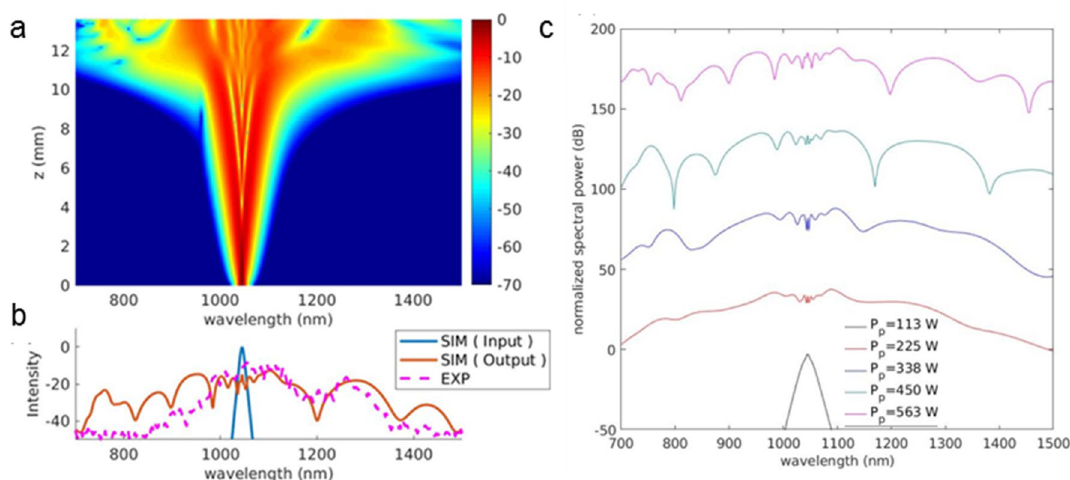
Figure 6. ( a ) Simulated SCG of TM 10 mode at the peak power of 563 W coupled into the Ta 2 O 5 waveguide: ( a ) spectral intensity; ( b ) comparison of the simulated (in red) and measured (in magenta) spectra at the output. The spectrum of the input pulse is shown in blue. ( c ) Estimated SC spectrum generated with ultrafast pulses of various peak powers coupled to the Ta 2 O 5